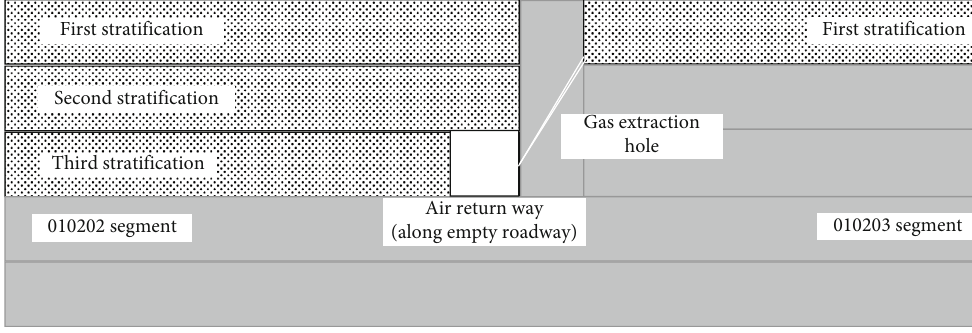
Figure 13: Layout of gas extraction in di ff erent level of mined out area.